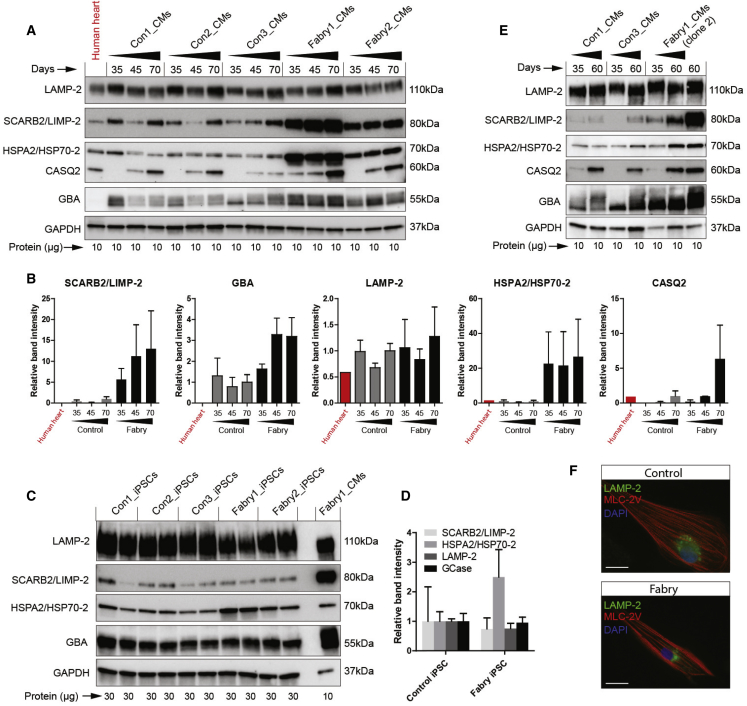
Validation of Candidate Fabry Protein Biomarkers by Western Blot(A) Western blots of control and Fabry CMs taken at three time points from three differentiations. Protein from a human heart lysate was loaded in the first lane.(B) Quantification of western blots in (A) grouped as control and Fabry, calculated as relative band density normalized to GAPDH levels.(C) Western blots of undifferentiated control and Fabry iPSCs with independent duplicates. A Fabry CM population is shown in the far right lane as reference.(D) Quantification of the iPSC western blots in (C), calculated as relative band density normalized to GAPDH levels.(E) Western blots showing the levels of the candidate Fabry biomarkers in CMs derived from a second clone of Fabry1 iPSCs at two time points of differentiation.(F) Immunocytochemistry showing typical LAMP-2 and MLC-2V staining in control and Fabry CMs. Bar data indicate the mean ± SD. Scale bar, 20 μm.See also Figure S3.